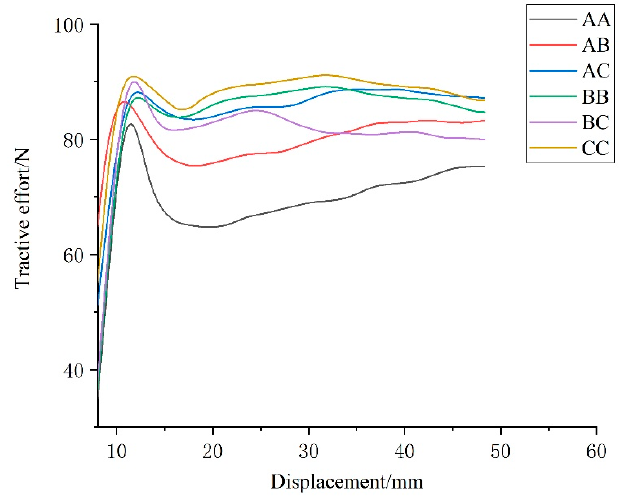
Figure 11. Tractive force during simulation of the six track shoes.